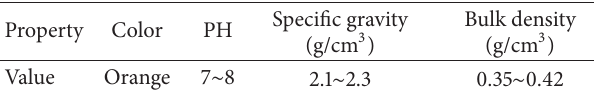
Table 2: Properties of diatomite.